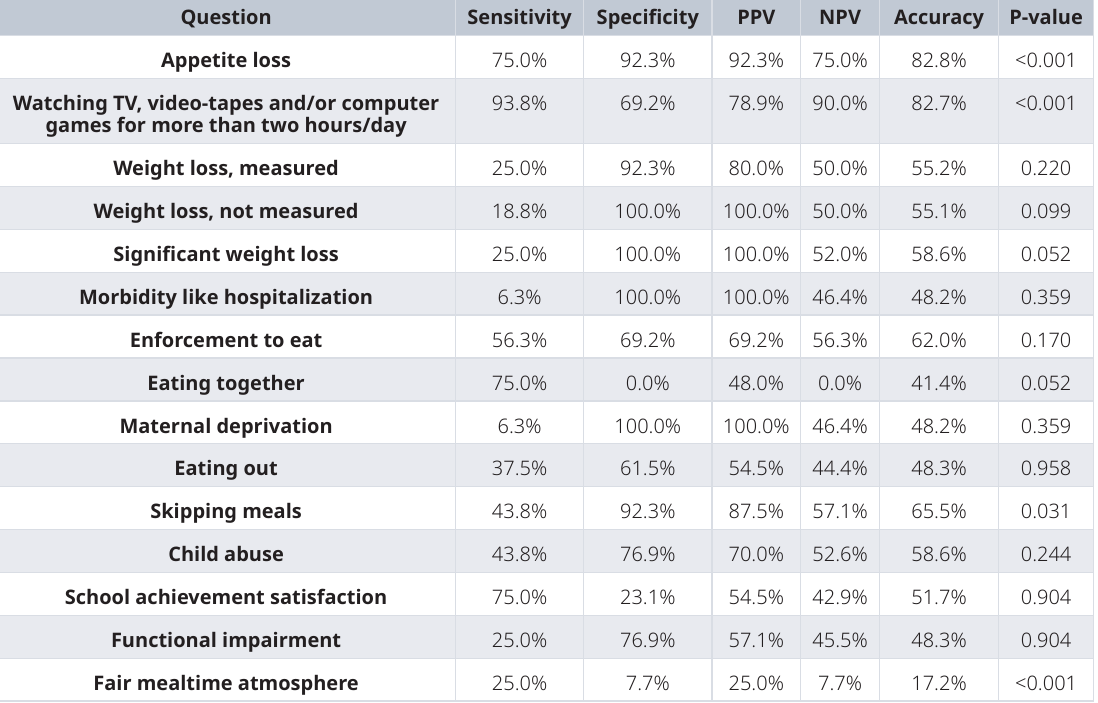
Table 8. Comparison between the screening questions and the subjective global assessment in the late childhood group.